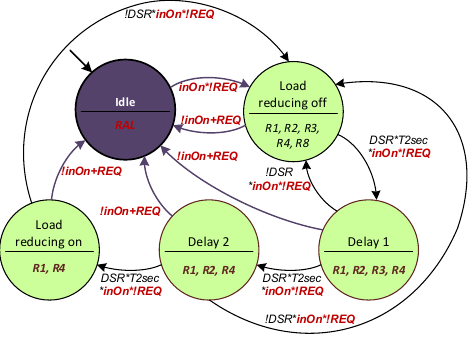
Figure 18. SHS—the “Load reducing 2” slave FSM.